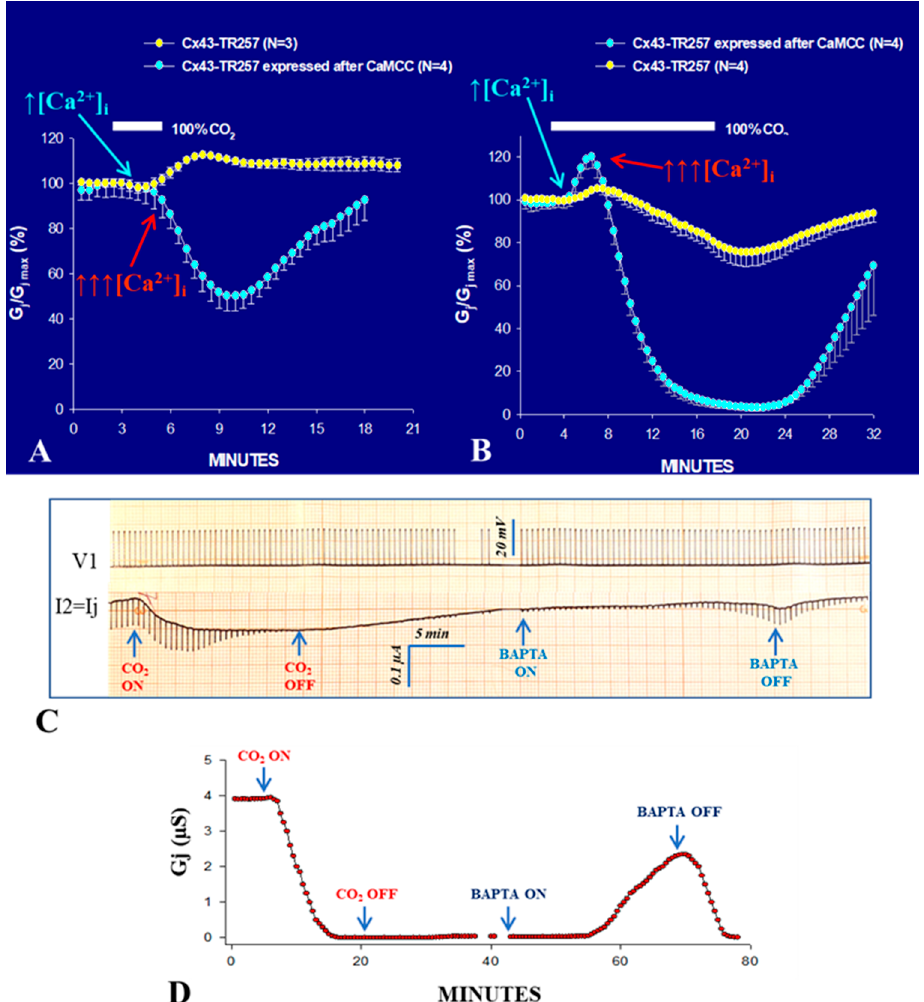
Figure 2. CT-deleted Cx43 channels (Cx43TR257), expressed after CaMCC, are much more sensitive to CO 2 than controls (A and B), as Gj rapidly drops to ~50% ( A ) and nearly 0% ( B ) with 3 and 15 min 100% CO 2 applications, respectively, while in controls Gj decreases by only ~25% even with 15 min CO 2 ( B ). Curiously, in controls paradoxically Gj increases reversibly with brief applications of CO 2 ( A ); similarly, Gj increases before dropping in control Cx43TR257 ( B ). The initial Gj rise may result from activation of the CaMKII cascade (see text). After CO 2 -washout, in some experiments, Gj remains indefinitely at nearly 0% ( C and D ), but reversibly increases with 180 µM BAPTA superfusion ( C and D ). An original voltage (V1 = Vj) and current (I2 = Ij) chart record is shown in C. The changes in Gj (µS) of the experiment shown in C are shown in D (Gj = Ij/Vj). These Cx43 data are mine, new and not published elsewhere.